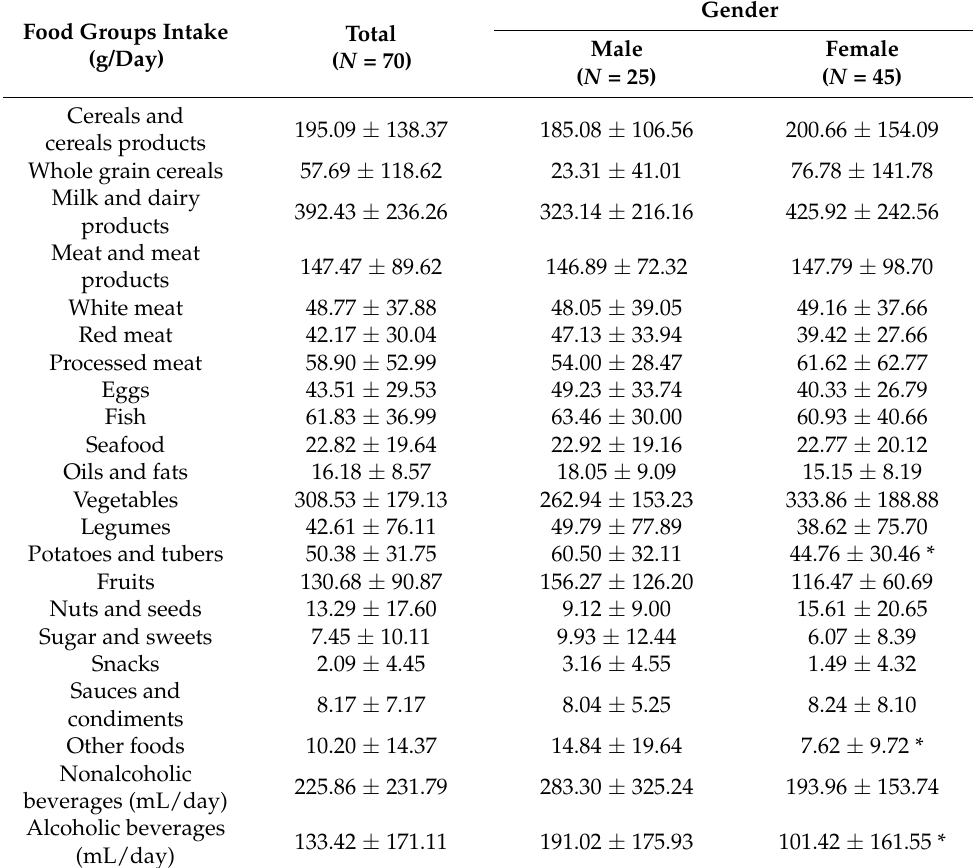
Table 2. Differences in the intake of the major food groups in the study sample, by gender.